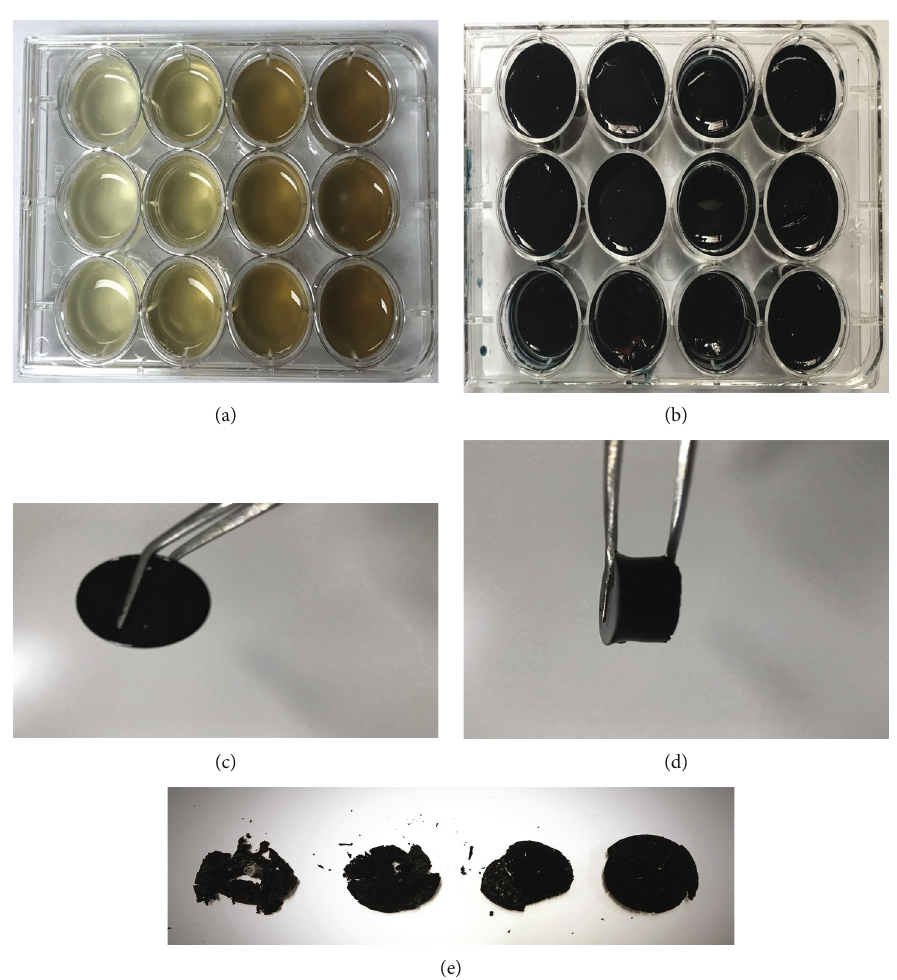
Figure 1: Features of CS/GO hydrogel sca ff olds (from left to right: the hydrogel sca ff olds with 0, 0.1, 0.5, and 1.0wt.%GO): (a) CS/GO hydrogel sca ff olds directly spread on a 12-well plate. (b) CS/GO hydrogel sca ff olds crosslinked for 24h. (c) Front view of the hydrogel sca ff olds. (d) Side view of the hydrogel sca ff olds. (e) CS/GO hydrogel sca ff olds after vacuum